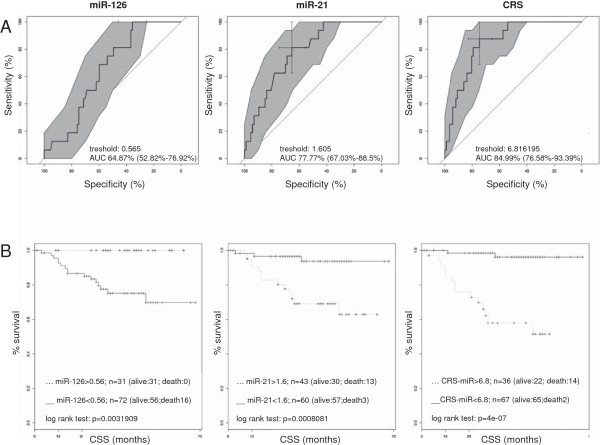
ROC curve of miRNA risk scores (miR-21, miR-126 and CRS) and Kaplan Meier survival analysis of cancer specific survival (CSS) in RCC patients stratified by miR-21, miR-126 and CRS expression data. A) ROC curves; the cross indicates the selected cutoff score for miR-21, miR126 or CRS resulting in highest sensitivity and specificity. The used cut-off scores were indicated in the graphs. B) Kaplan Meier curves with log rank test and numbers of patients stratified by the calculated risk scores of miR-21, miR-126 and CRS.